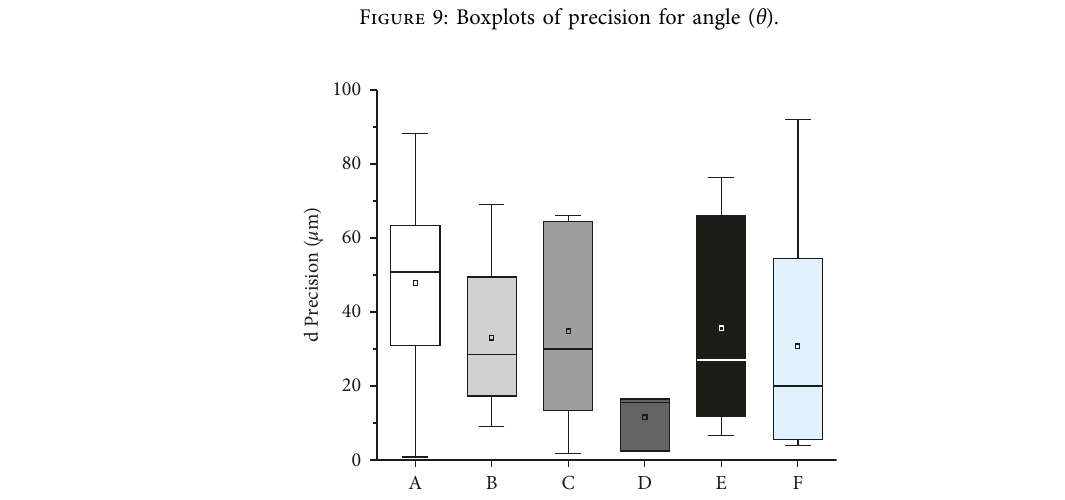
Figure 9: Boxplots of precision for angle ( θ ).